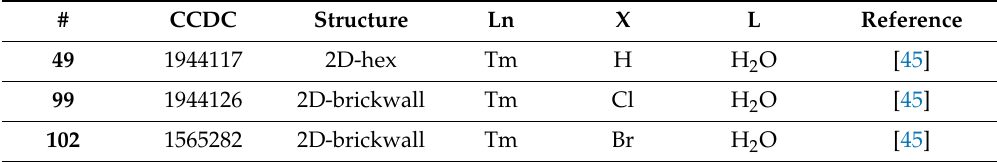
Table 25. Structurally characterized Tm(III) compounds with anilato